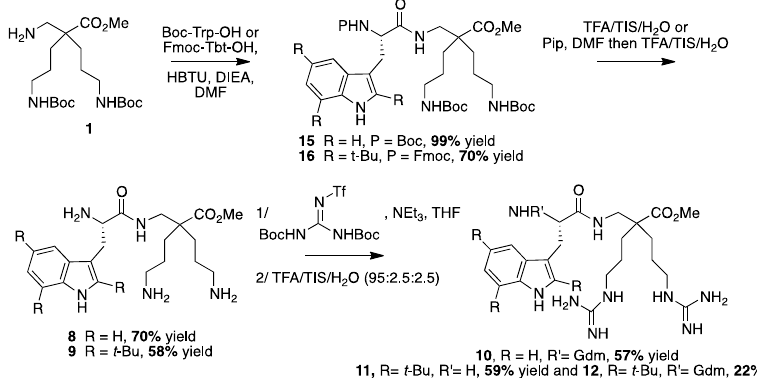
Figure 15 . HPLC profile of Gua-Tbt- β 2,2 h bis-Arg-OMe 12 .